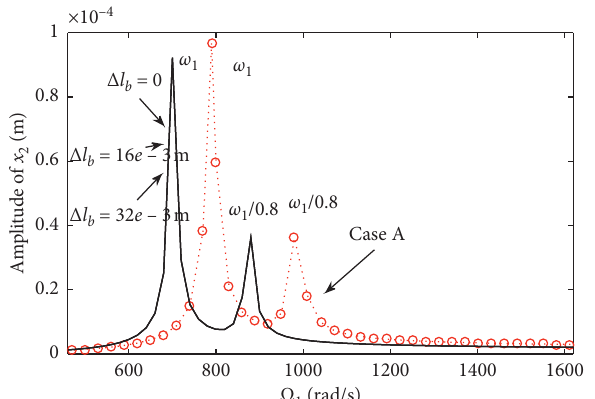
Figure 8: Vibration amplitudes of node 13 versus rotation speeds for different Δ l b .